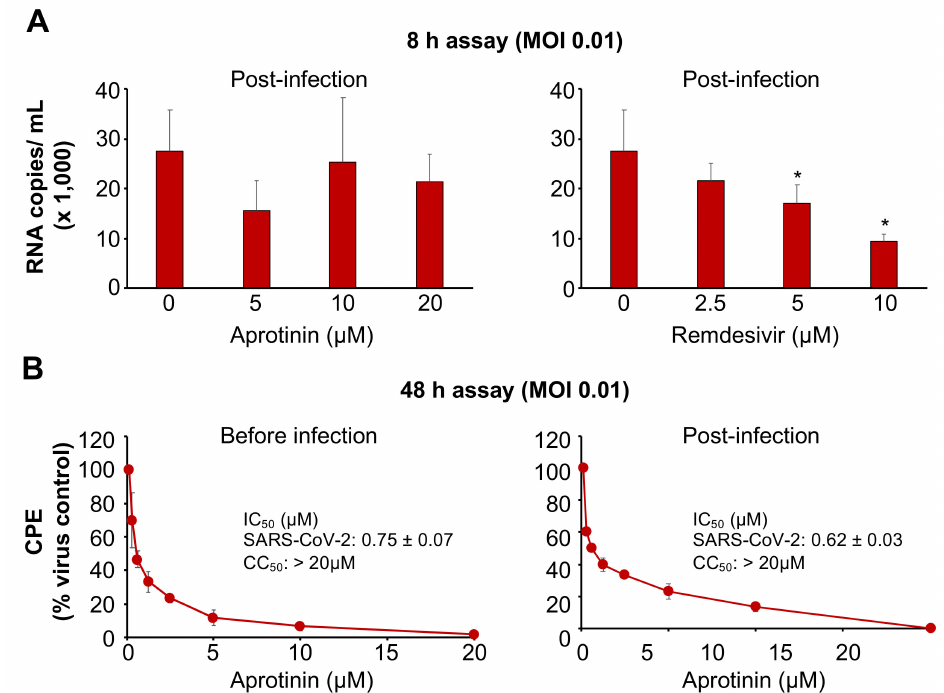
Figure 3. Anti-SARS-CoV-2 e ff ects of aprotinin when administered post-infection. For post-infection experiments, the cells were incubated with the virus for a one-hour adsorption period. Then, the cells were washed three times in PBS prior to the addition of the drug. ( A ) The e ff ects of aprotinin and the RNA polymerase inhibitor remdesivir (a positive control drug that interferes with virus replication after virus entry) on virus replication as determined by qPCR in SARS-CoV-2 / FFM1 (MOI of 0.1)-infected Caco2 cells 8 h post-infection (after approximately one round of replication). * p < 0.05 as determined by one-way ANOVA and Dunnett’s multiple comparison test. ( B ) The e ff ects of aprotinin on cytopathogenic e ff ect (CPE) formation in SARS-CoV-2 / FFM1 (MOI of 0.01)-infected Caco2 cells were determined 48 h